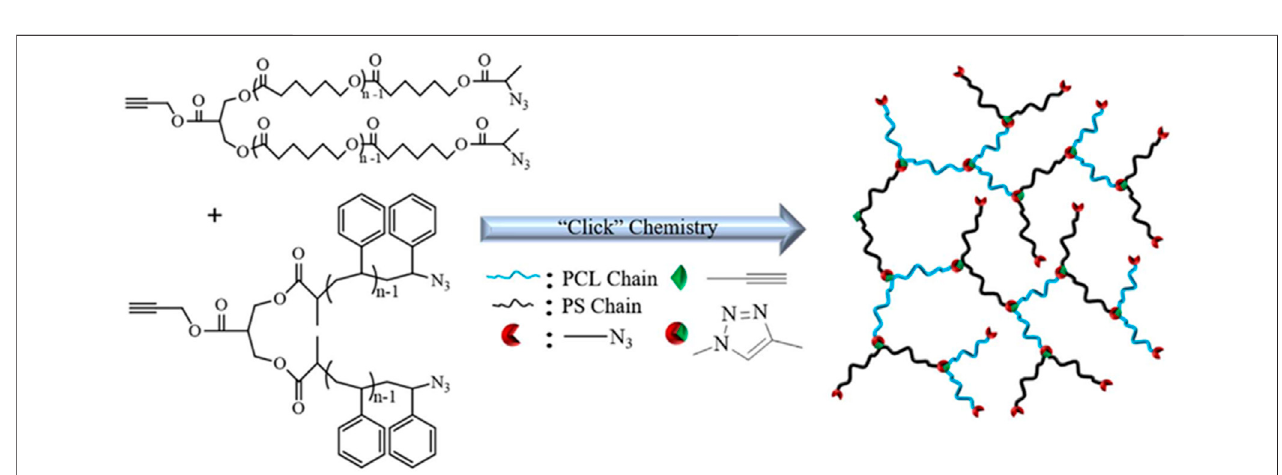
FIGURE 9 | Synthesis of hyperbranched polymers by azide-alkyne Huisgen cycloaddition (Ye et al., 2020).